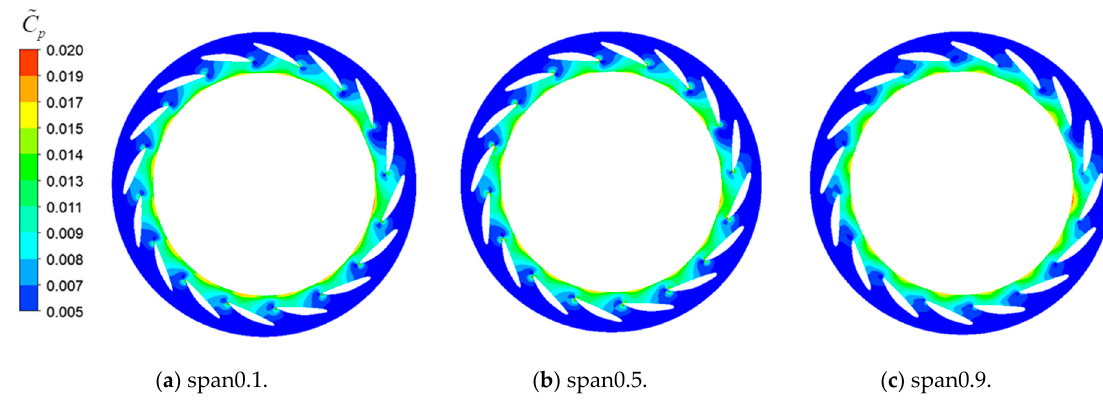
Figure 19. Pressure fluctuation distributions at different vane heights at 1.25 Q d .